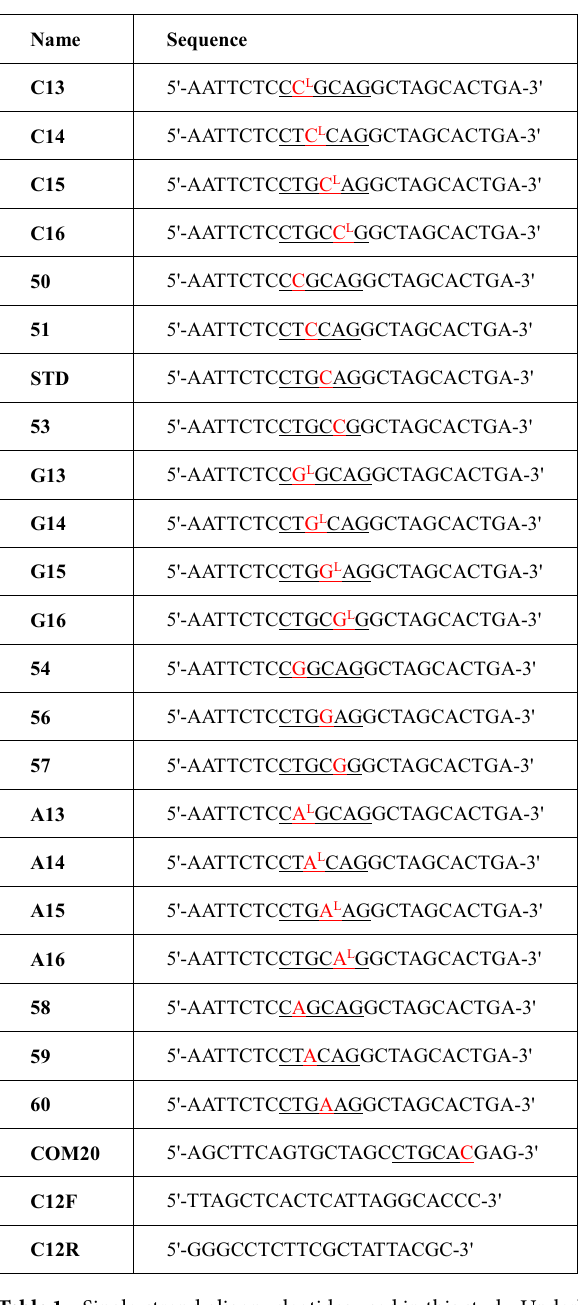
Table 1. Single-strand oligonucleotides used in this study. Underlined sequences : nucleoside (red site) of PstI recognition site was replaced by l-nucleosides and natural nucleosides,